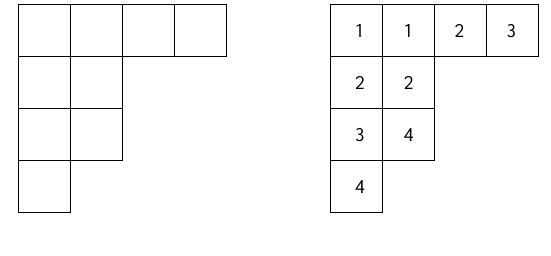
4 2 2 1 (cid:3)(cid:1)(cid:0) (cid:1) (cid:2) (cid:2) (cid:2)